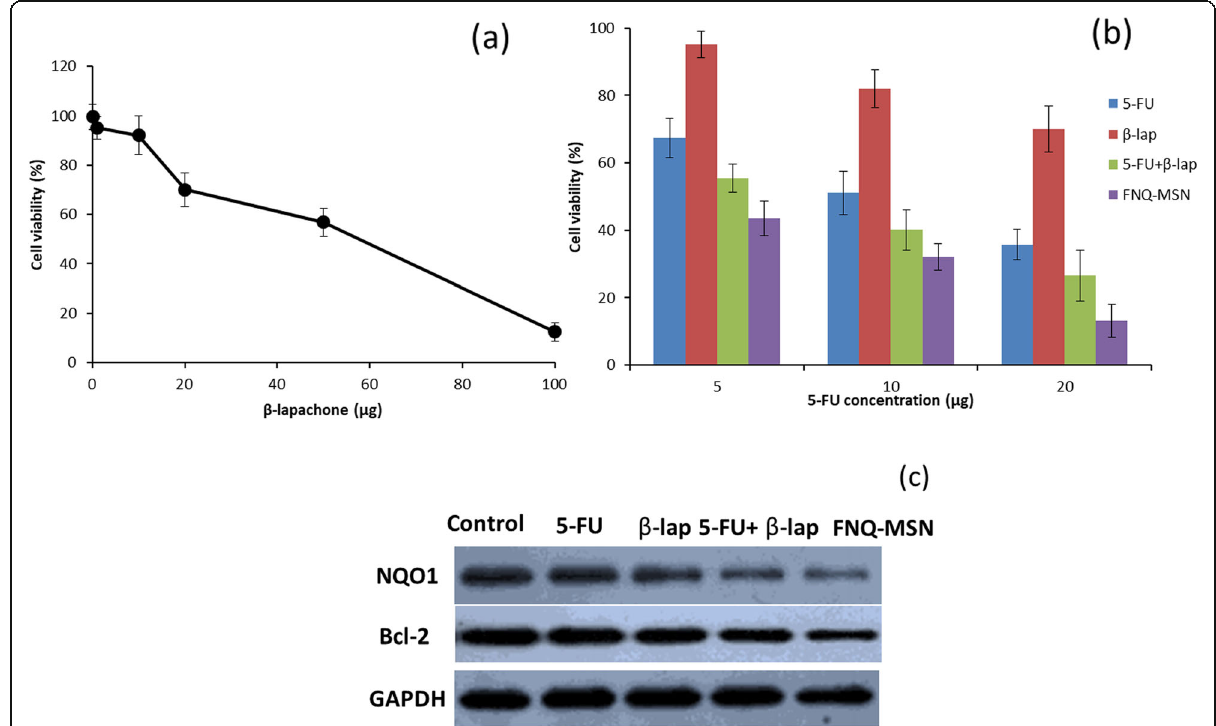
Fig. 4 a Effect of concentration-dependent activity of ß-lap on the cell viability of Cal33 cells. b Cytotoxic effect of individual and combination with second chemotherapeutic agent, 5-FU at 3 different concentrations of 5 – 20 μ g/ml, respectively. The cell viability was evaluated by MTT assay after 24 h of incubation. c Western blot analysis of NQO1 and Bcl-2 protein expression after treatment with individual and combination of 5-FU and